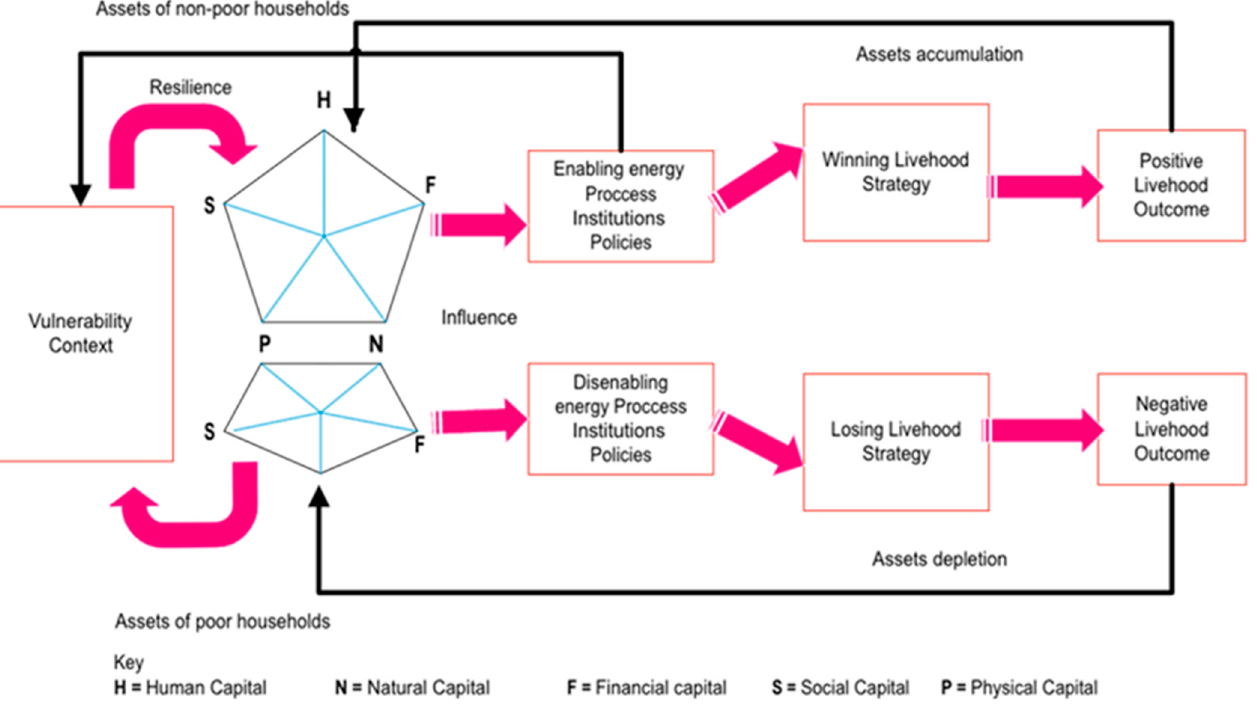
Figure 1. General vision of sustainable livelihoods framework (FAO) modified for energy projects in remote communities. remote